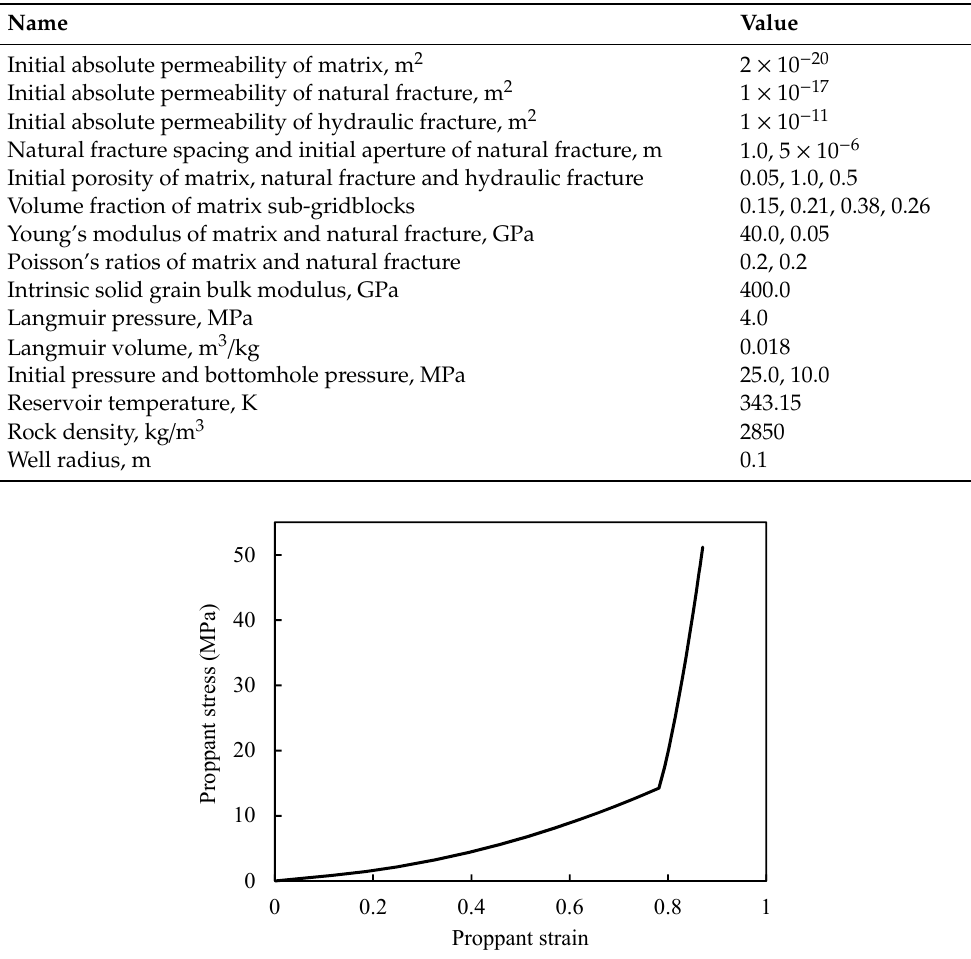
Figure 12. The nonlinear stress–strain curve of proppant deformation, modified from Liu et al. (2018) [14].